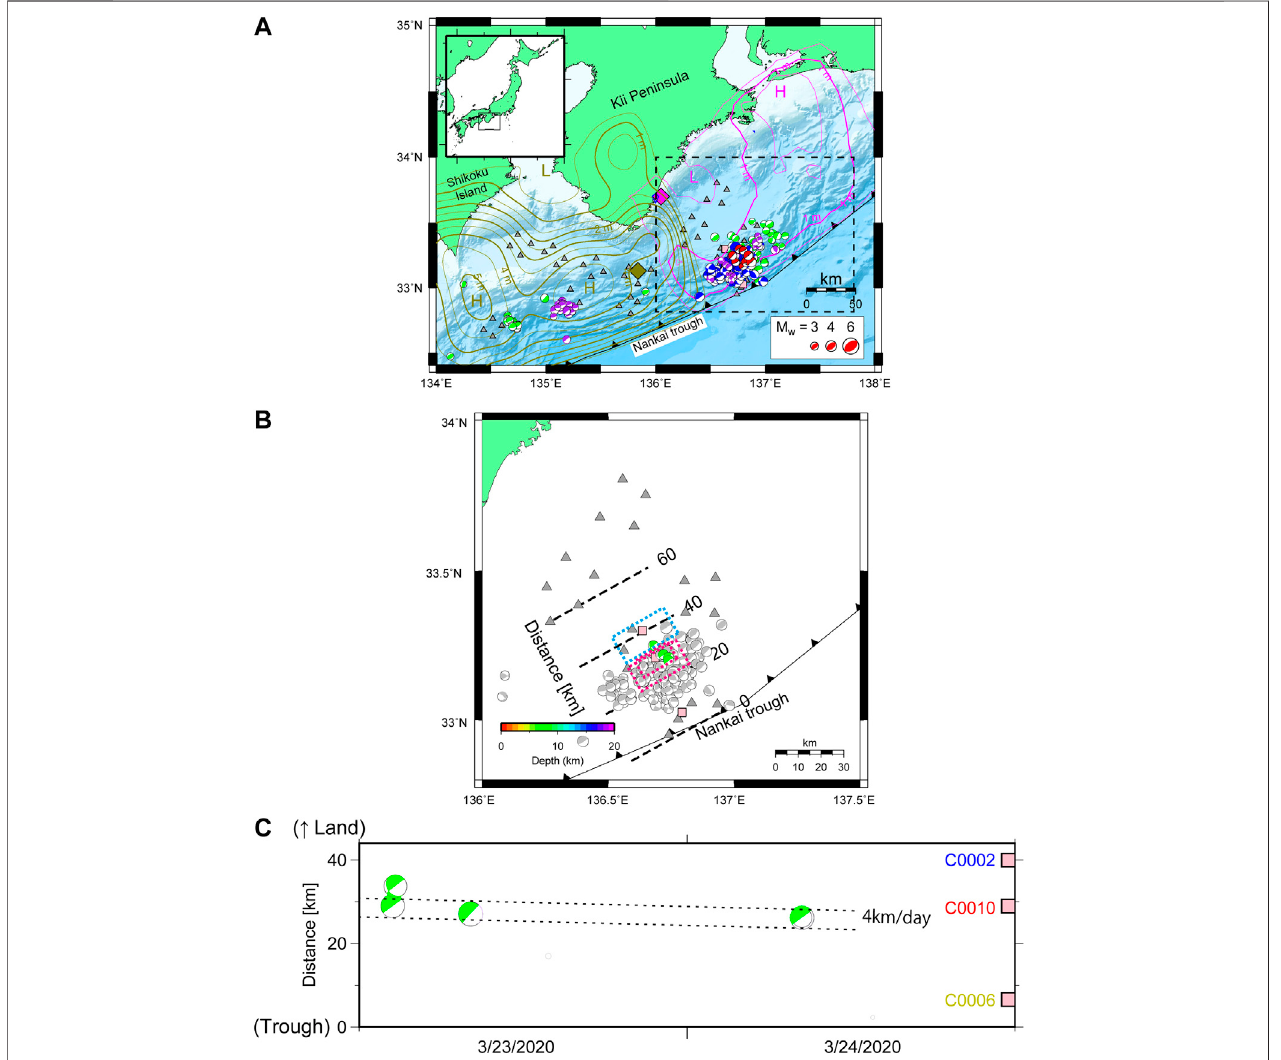
FIGURE 4 | (A) Past seismic activities in the study area. The gray triangles represent the locations of the DONET stations. The epicentral distribution of the focal mechanismforthesVLFEoccurredin2003 – 2004(green:ObaraandIto,2005;ItoandObara2006),2009(red:Sugiokaetal.,2012),2015(purple:Nakanoetal.,2016), and2016(blue:Nakanoetal.,2018).Epicentersofthe1944Tonankaiand1946Nankaiearthquakesarerepresentedbymagentaandolivediamonds,respectively.The magenta and olive contours are the same as Figure 1A . (B) Closeup of the rectangle region enclosed by black broken lines in (A) . The gray and green focal mechanisms represent the sVLFE catalog in 2016 (Nakano et al., 2018) and the latest one accompanied by the pore pressure event, respectively. The pink squares representtheboreholestationsburiedwiththefocalmechanismin (A) .ThedottedrectanglesrepresentthefaultmodelsofCaseA-1(cyan)andCaseA-2(magenta)(A-2 is smaller, A-2+ islarger) for the pore pressure event ( Figure 6 ). (C) Activitiesof the sVLFEs in March 2020along the dip direction from the Nankai Trough with the same colorscaleofthedepthpro fi lein (B) .Thedottedlinesdepictthemigrationspeedat4 km/dayestimatedbyNakanoetal.(2018),wheretheintervalofthetwodottedlines is 5 km as a spatial resolution for the epicenter determination.